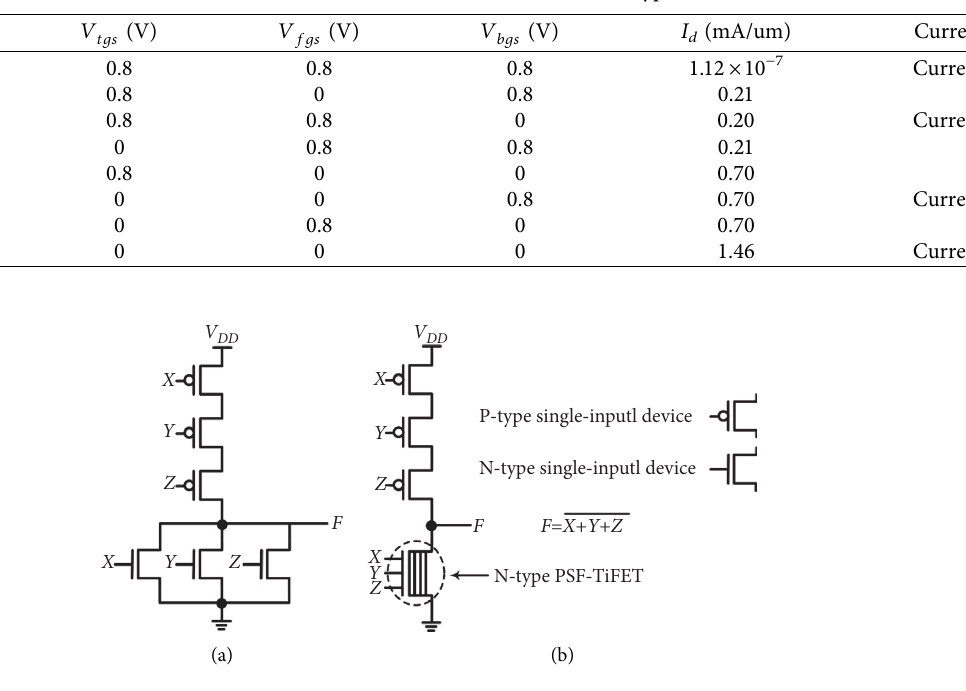
Figure 13: The three-input NOR gate using (a) the single-input device and (b) the PSF-TiFET device.